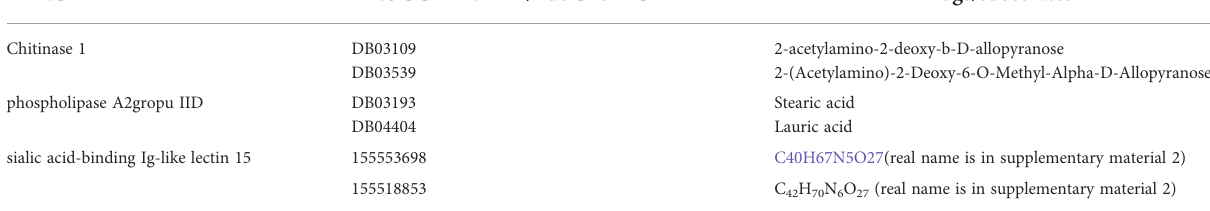
TABLE 3 Targeted drugs of related genes in Drugbank and